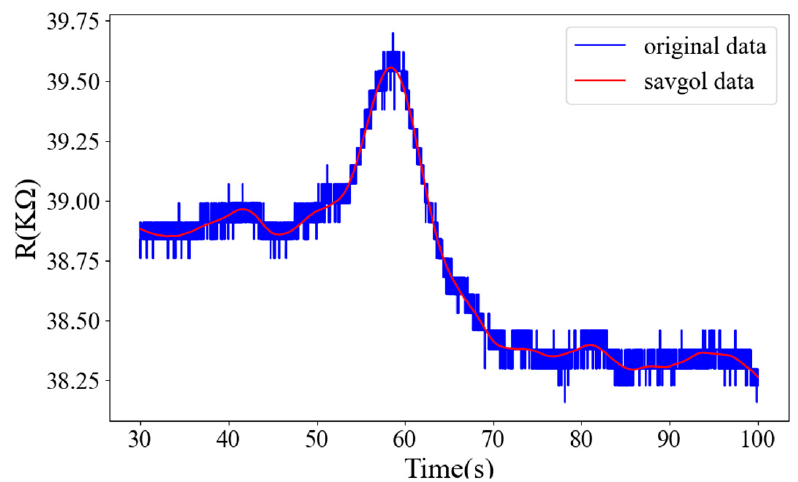
Figure 4. Comparison diagram of gas response data curve with or without filtering.